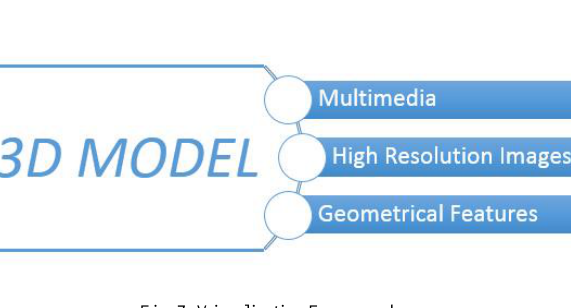
Fig. 6. Mithraeum of Multicoloured Marbles, 3D Texturized Model